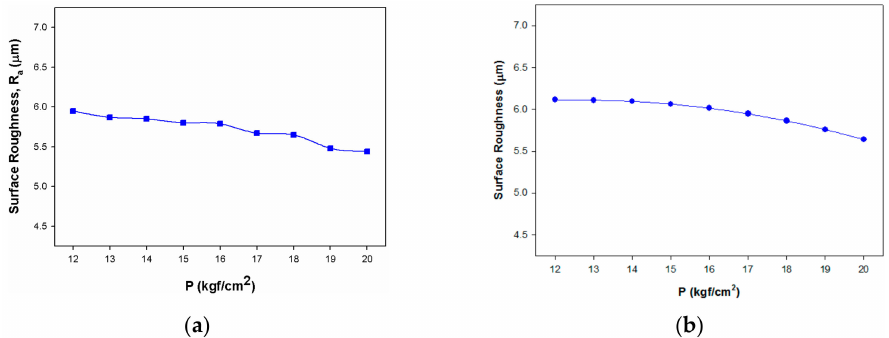
Figure 13. Main effect plots for SR with P using ( a ) DOE model; ( b ) machine learning model.